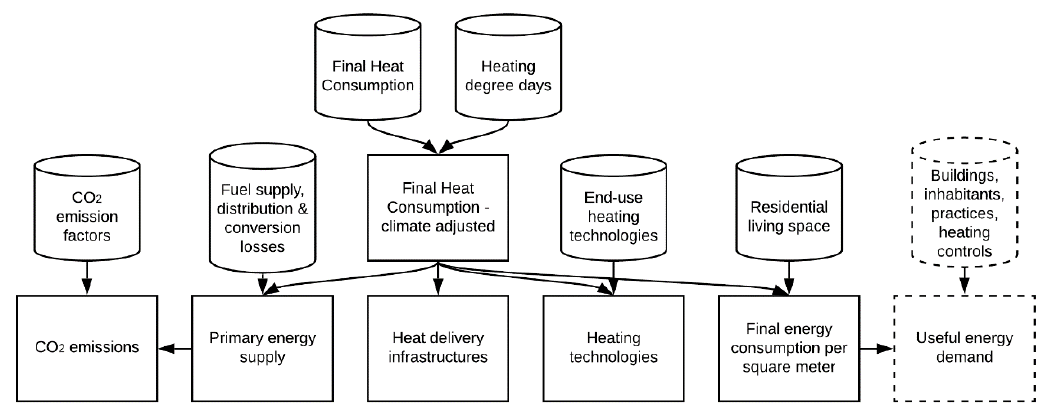
Figure 1. Representation of the data structure and relation between datasets used for the analysis in this paper. Useful energy demand is in a dashed box as this could not be estimated for this paper due to missing data.